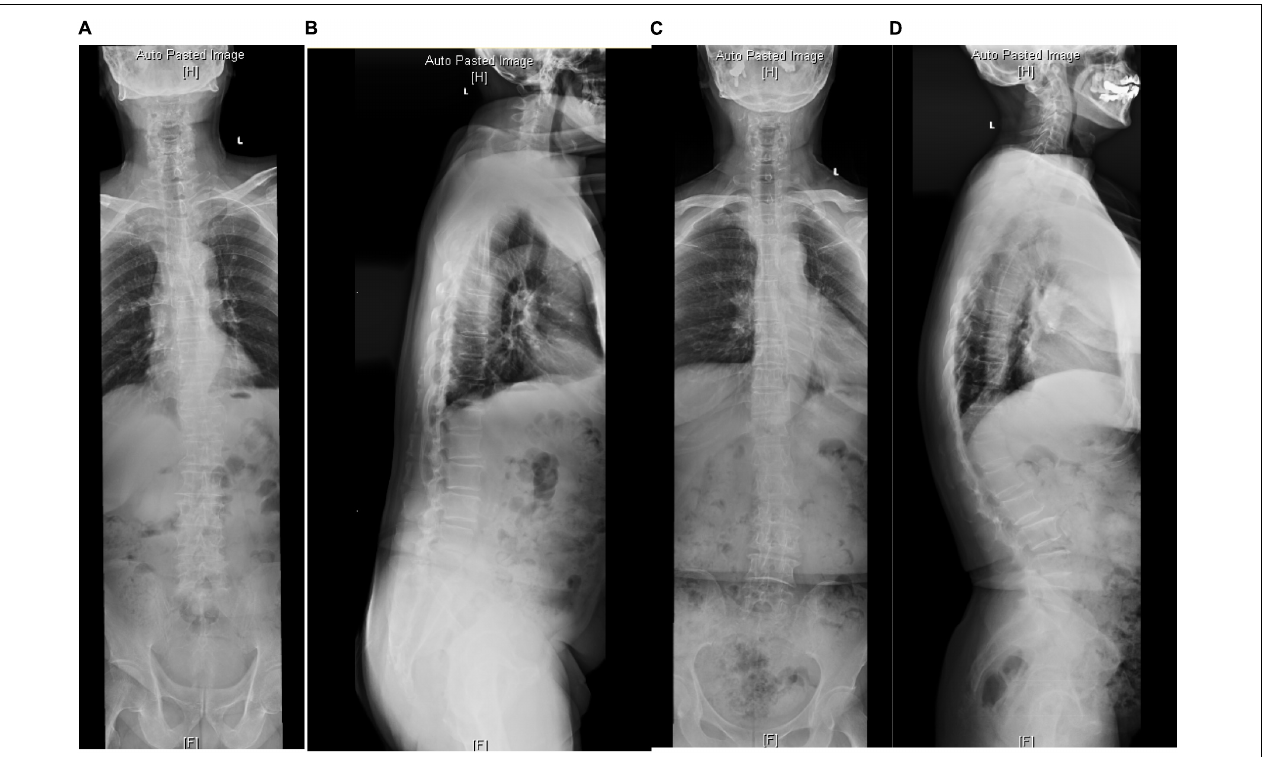
FIGURE 2 | The radiological parameters measured on standard anterior-posterior and lateral whole spine X-ray of cases from the SIB group. (A,B) In a 68-year-old woman, TK = 16.4, TLK = 1.1, LL = 19.5, PI = 63.4, PT = 39.9. (C,D) In a 72-year-old man, TK = 40.9, TLK = 40, LL = 72.2, PI = 51.7, PT =